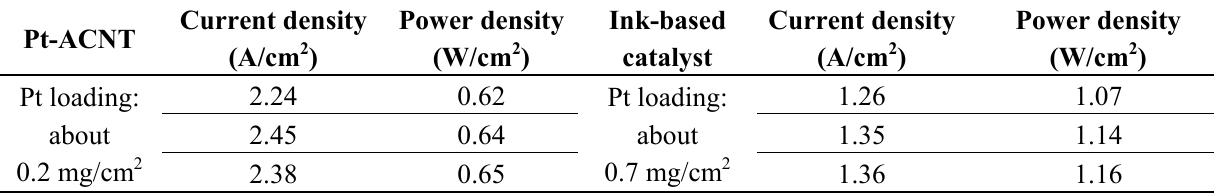
Table 1. The comparison of PEMFC performance between Pt-ACNT catalyst and commercially-available ink-based